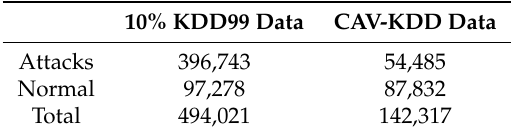
Table 4. Amount of normal and attack data in the training data sets.